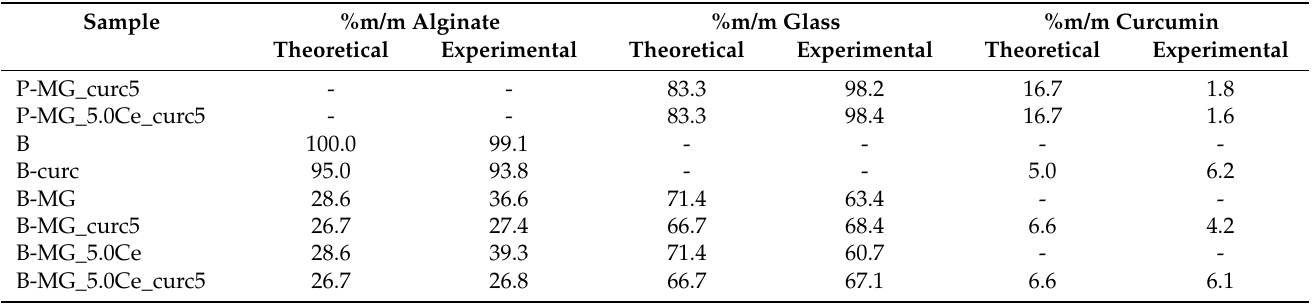
Table 1. Theoretical and experimental compositions of the samples synthesized *.